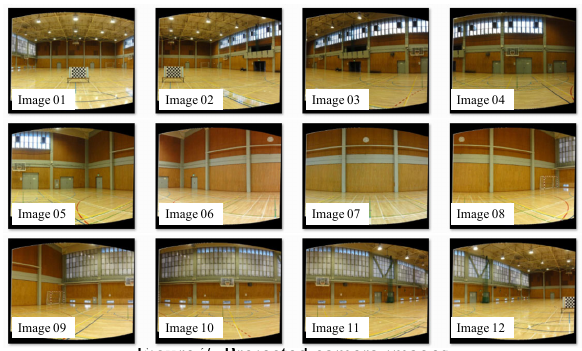
Figure 7. Projected camera images